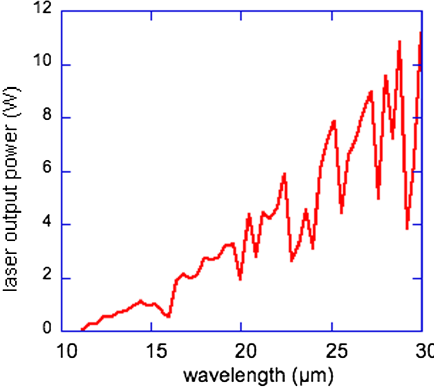
FIG. 23. Laser power versus wavelength, without extraction hole (transmission